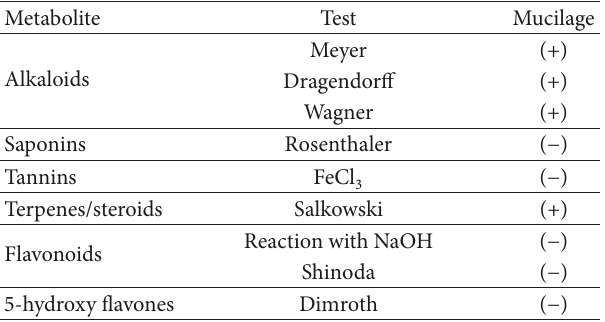
Table 5: Phytochemical analysis of O. cochenillifera mucilage.